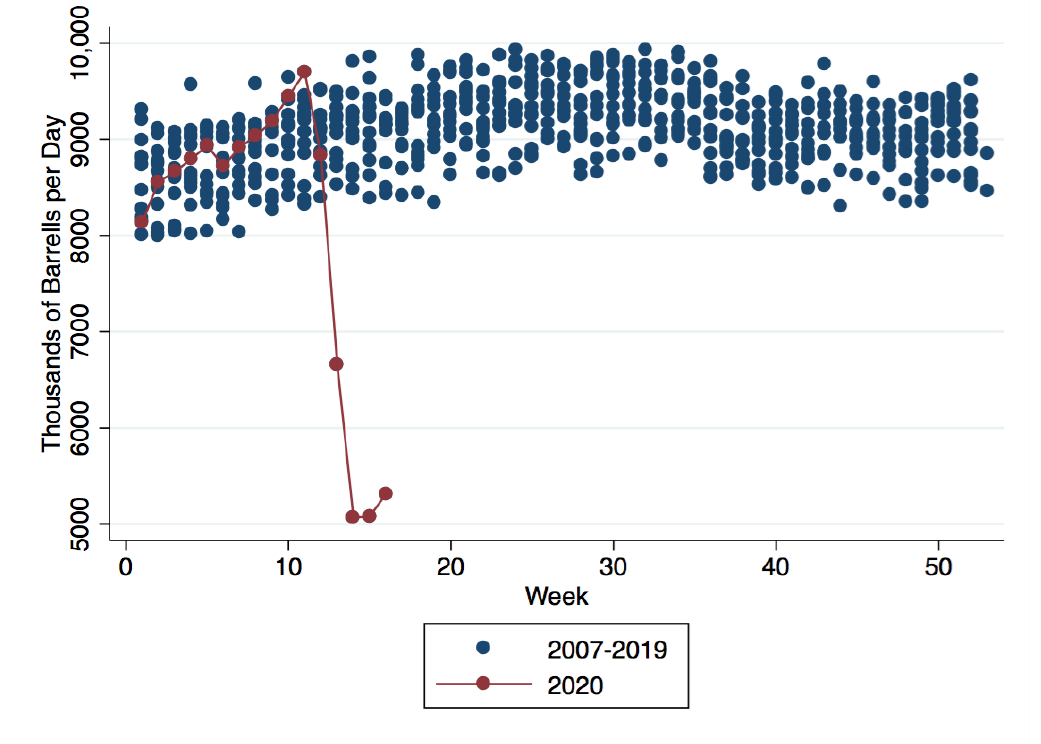
Figure A3. lU.S. product supplied of finished motor gasoline. Notes: Data from